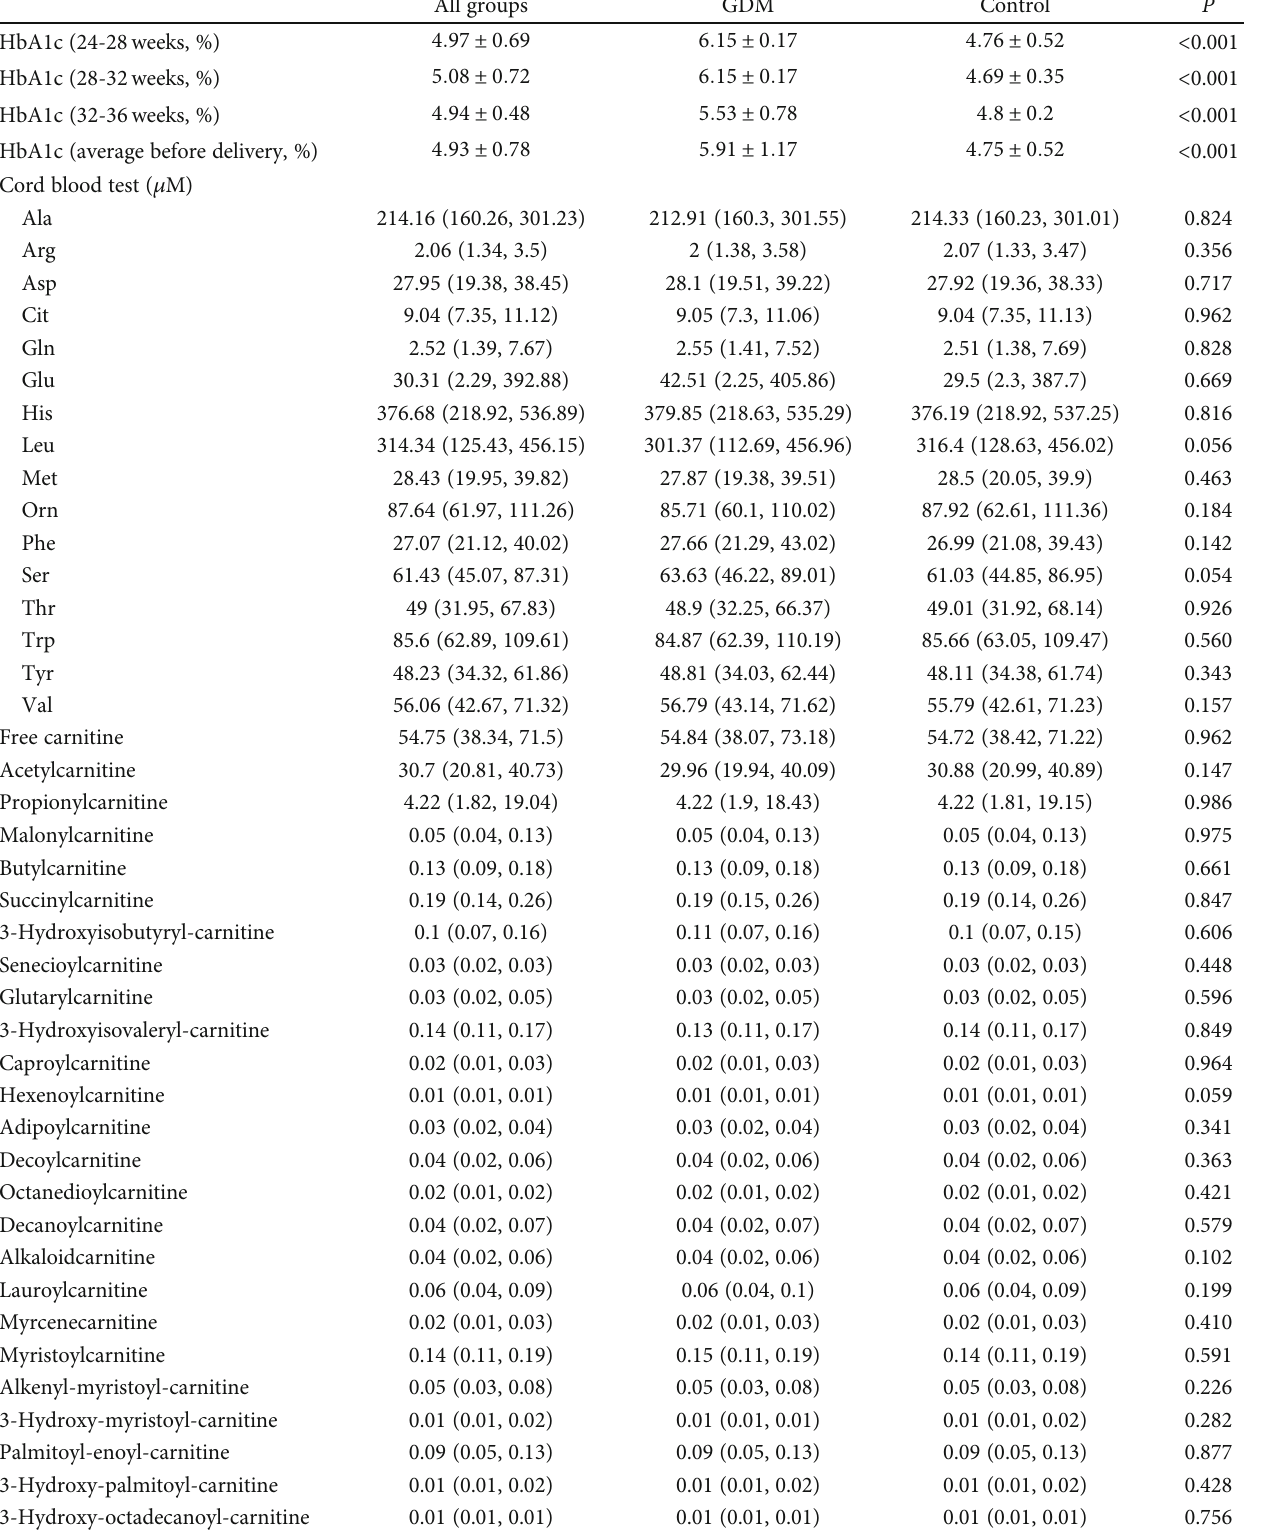
Table 3: Blood tests on pregnant women and neonates. All groups